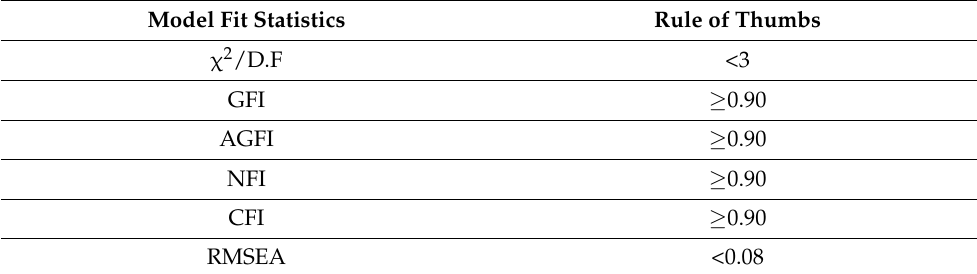
Table 1. The thresholds of the CFA and SEM.